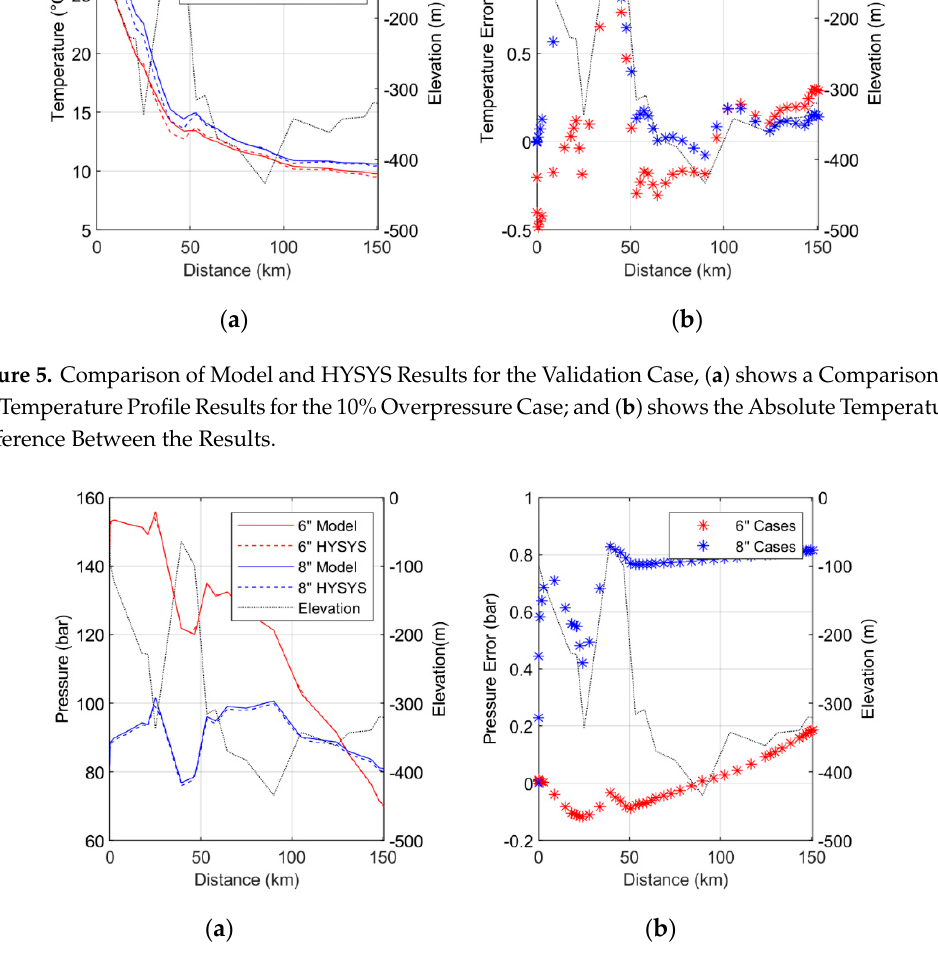
Figure 6. Comparison of Model and HYSYS Results for the Validation Case: ( a ) Shows a Comparison of the Pressure Profile Results for the 10% Overpressure Case; and ( b ) Shows the Absolute Pressure Difference Between the Two Sets of Results.